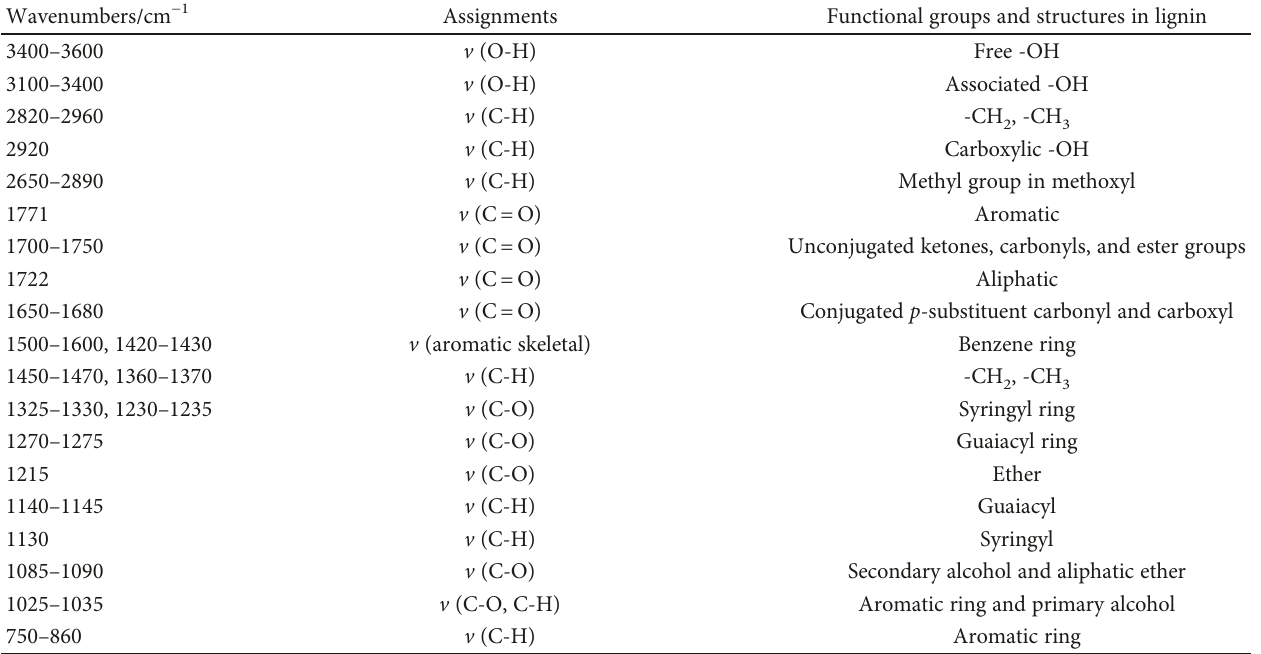
Table 3: Assignments of signals in 1 H NMR spectrum to typical functional groups in lignin (in CD Chemical